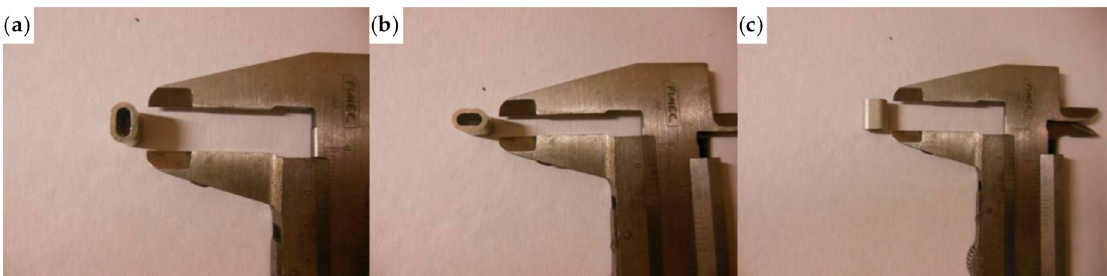
Figure 23. The ferrules of the experimentation: ( a ) longitudinal dimension; ( b ) transversal dimension; and ( c ) thickness.